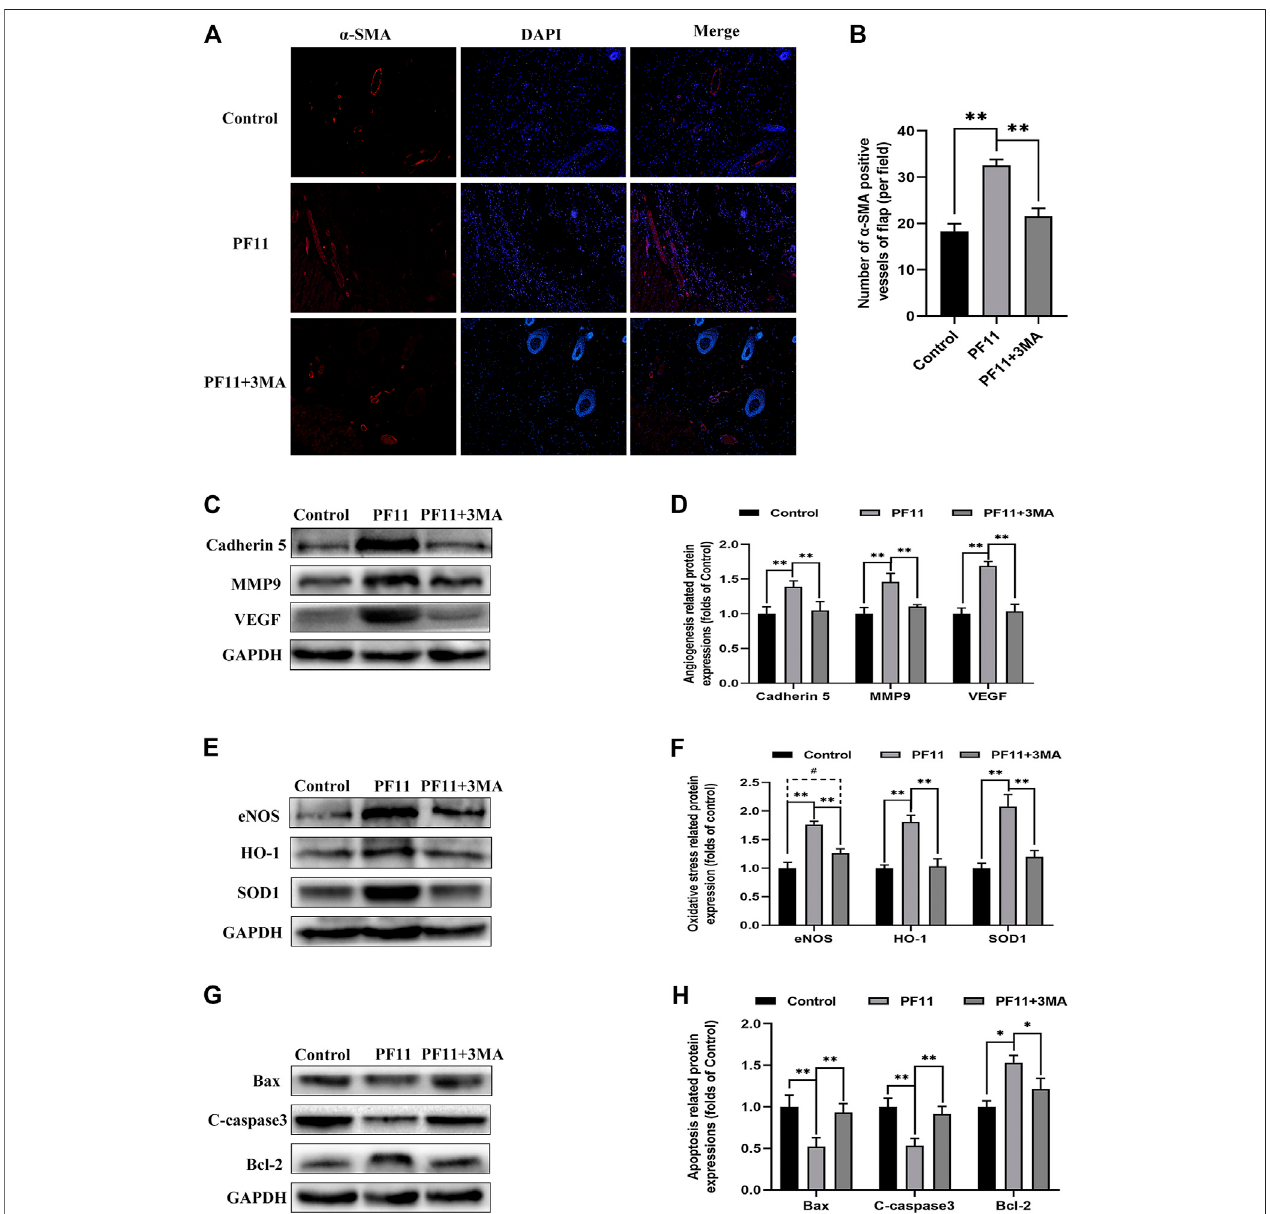
FIGURE 6 | Inhibition of autophagy abolished the positive effects of PF11 on angiogenesis, apoptosis, oxidative stress in skin fl aps. (A,B) Immuno fl uorescence staining showed the α -SMA positive microvessels in the control, PF11, and PF11 + 3MA groups (scale bar: 20 µm). (C,D) Western blotting results exhibited the expression of angiogenesis-related protein MMP9, VEGF, and Cadherin 5. (E,F) Western blotting results exhibited the expression of oxidative stress-related protein SOD1, HO1, and eNOS in the control, PF11, and PF11 + 3MA groups. (G,H) Western blotting results exhibited the expression of apoptosis-related protein Bax, Bcl-2, and C-caspase3. Values are expressed as means ± SD, n (cid:2) 6 per group. * p < 0.05 and ** p < 0.01, vs. PF11 group. # p < 0.05 and ## p < 0.01, vs. control group. # p < 0.05 and ## p < 0.01, vs. control group.